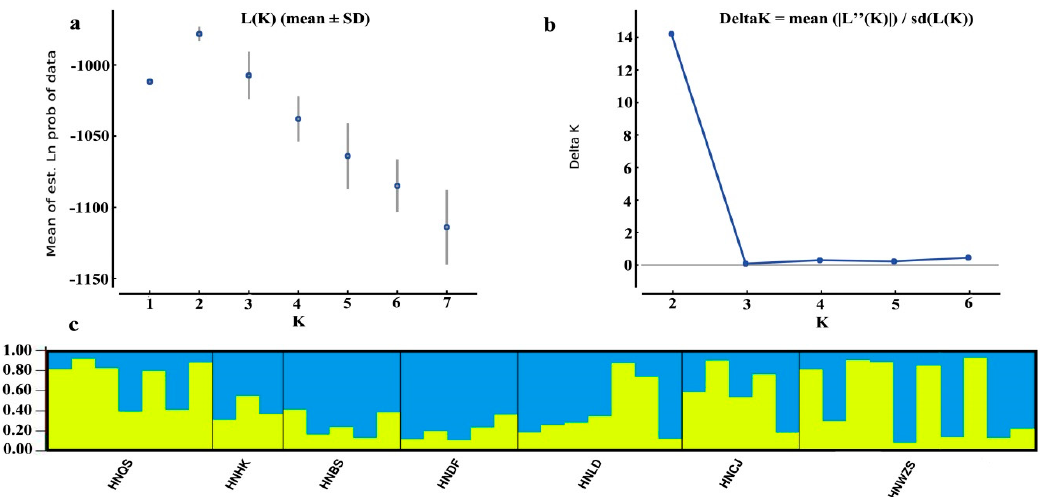
Figure 2. Results of STRUCTURE analysis for 42 D. odorifera individuals based on microsatellite data.